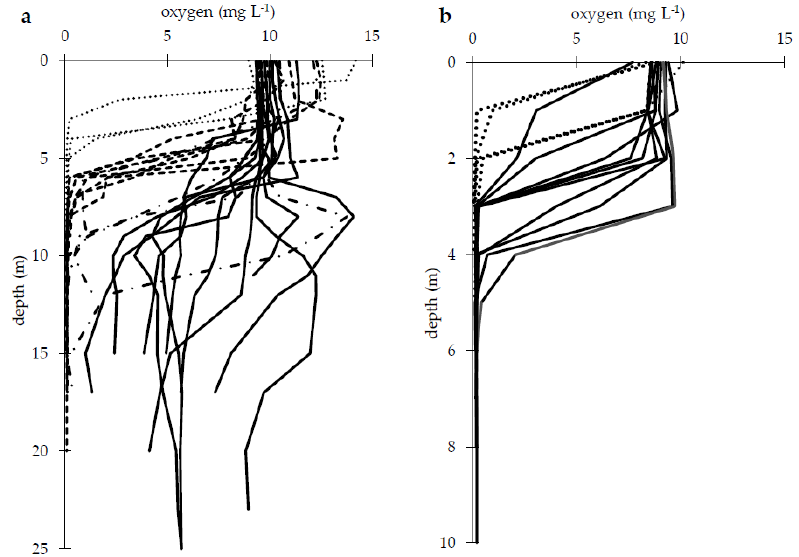
Figure 2. Oxygen profiles in harmonic lakes ( a ) and dystrophic lakes ( b ). Different types of lines represent different groups of lakes according to oxygen deficits. In harmonic lakes ( a ) solid lines represent lakes without anoxia (G1), dash-dot lines for lakes with anoxia in hypolimnion (G2); dashed line for lakes with anoxia from metalimnion (G3); dotted lines for lakes with anoxia from epilimnion (G4). In dystrophic lakes ( b ) solid lines for lakes with anoxia from 3–5 m (G5); dotted lines for lakes with anoxic conditions from 1–2 m (G6); Detailed list of lakes in Table